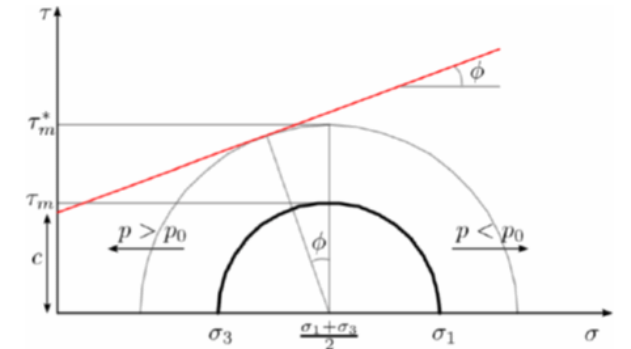
Figure 1. Stress state in the plane σ – τ and displacement of the Mohr–Coulomb circle following storage ( p > p 0 ) or production ( p < p 0